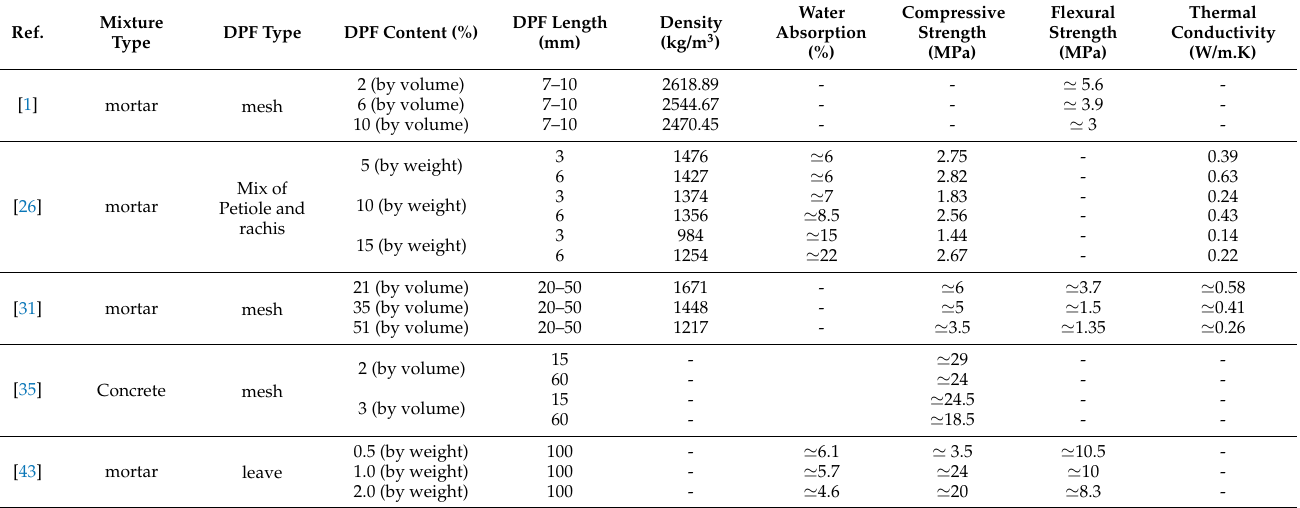
Table 6. Physical, mechanical, and thermal properties of concretes and mortars containing DPF